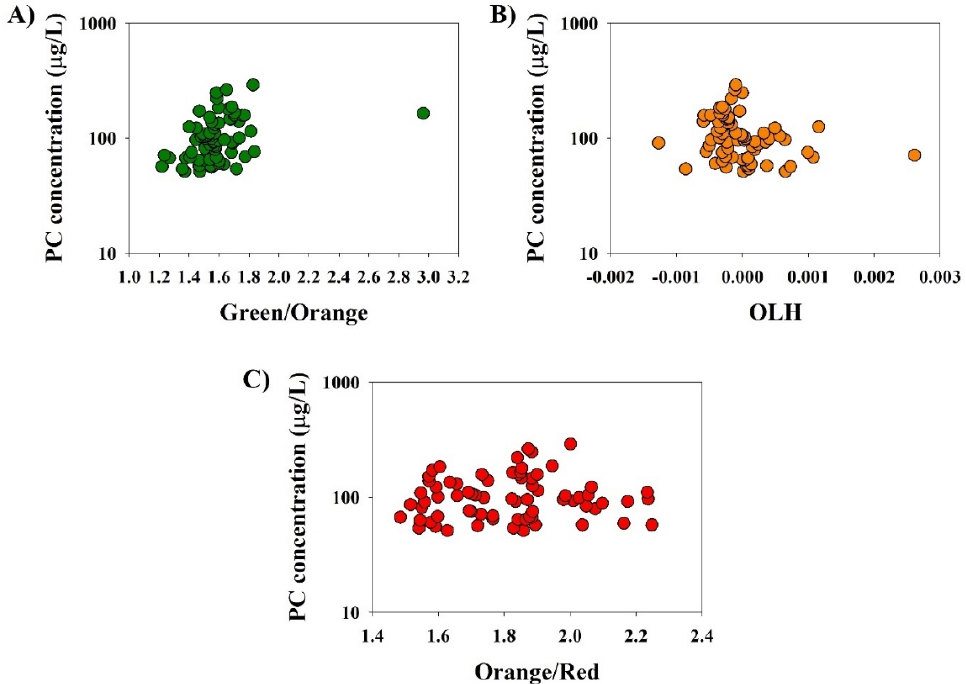
Figure 4. PC concentration (in log scale) and remote sensing models relationship using only the data in which PC concentration was higher than 50 μg/L ( n = 72). ( A ) for the green:orange ratio; ( B ) for the OLH; and ( C ) for the orange:red ratio.